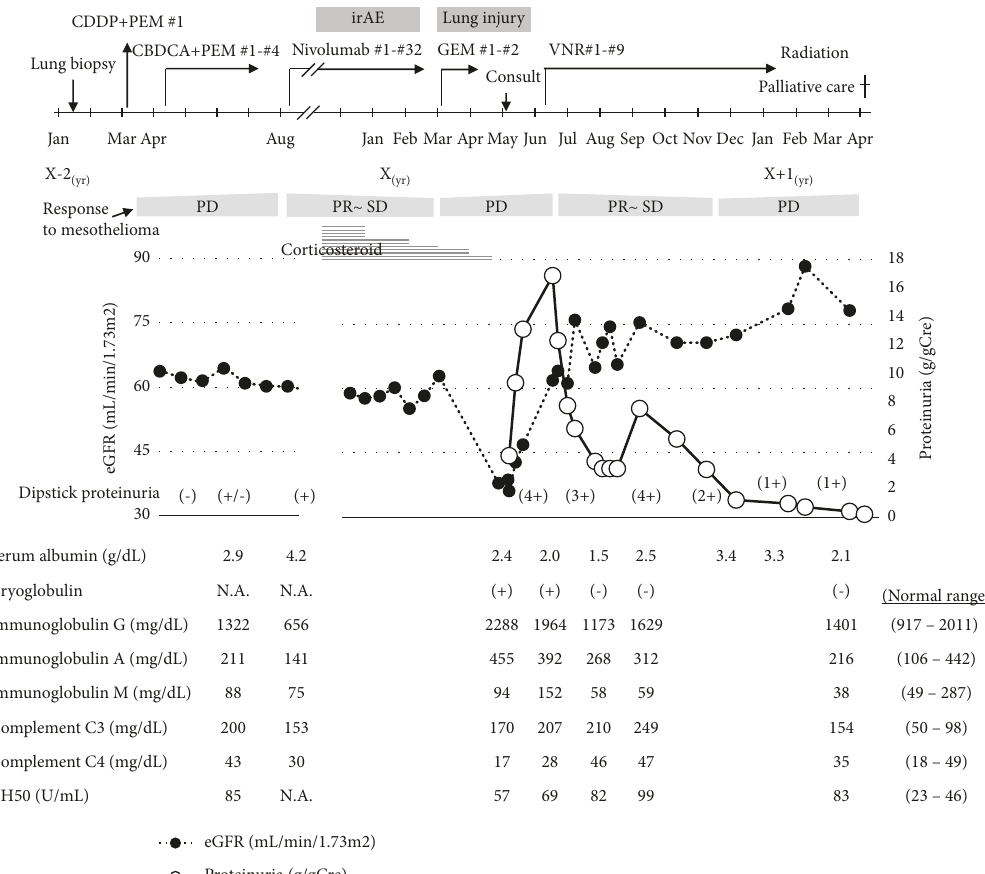
Figure 1: The clinical course of the patient. Two years earlier, the patient had been diagnosed with malignant mesothelioma by lung biopsy and treated with chemotherapy. Cisplatin plus pemetrexed (CDDP+ PEM) and carboplatin plus pemetrexed (CBDCA+PEM) were determined to result in an insufficient response, and nivolumab was considered to have induced immune-related adverse events and was discontinued. After starting the administration of gemcitabine (GEM), drug-induced lung injury occurred. He was also referred to a nephrologist because of the subsequent development of edema, renal injury, and proteinuria. After investigations and careful consideration, vinorelbine (VNR) was administered to treat the nephrotic syndrome with cryoglobulinemia due to the progression of malignant me- sothelioma. Response of chemotherapy to malignant mesothelioma is presented as partial response (PR), stable disease (SD), and pro- gressive disease (PD). Palliative care was subsequently provided, along with radiation therapy for metastatic bone lesions and antibiotics against bacterial pneumonia. The patient died a little over 3 years after the pathological diagnosis of mesothelioma without recurrence of nephrotic syndrome in the end-stage of